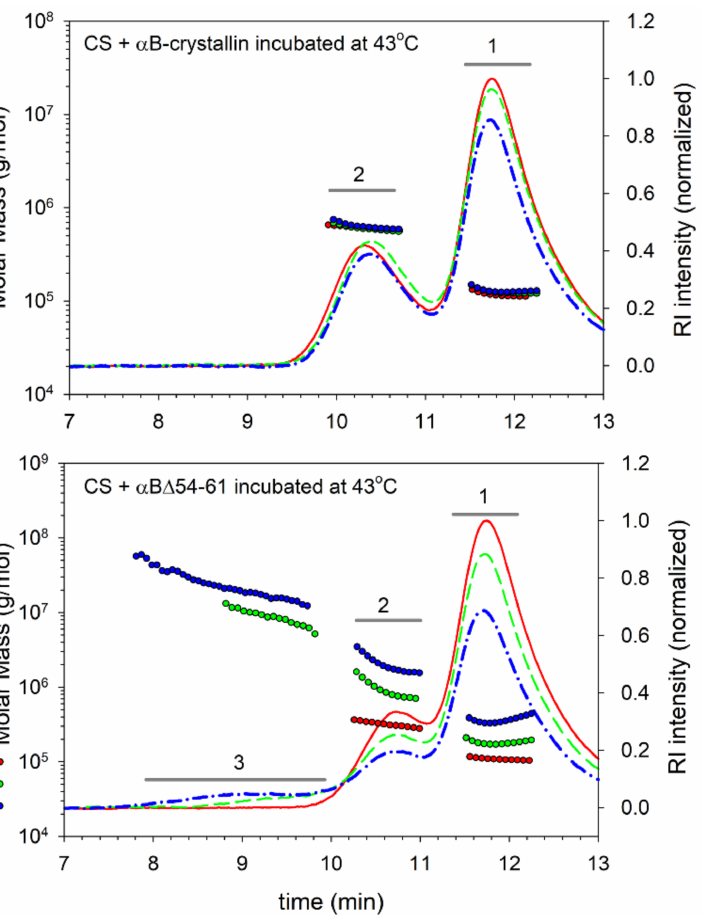
Figure 4. Refractive index profiles of chaperone–substrate complexes showing the molar mass distribution across the peaks. MALS analysis of α B-wt or α B ∆ 54–61 and CS incubation mixtures at different time points: red line—0 min, green line—40 min, blue line—80 min incubation. The upper panel shows the molar mass distribution in the incubation mixtures of α B-wt and CS. The lower panel shows molar mass analysis of α B ∆ 54–61 and CS after incubation. Other experimental details are included under the Methods